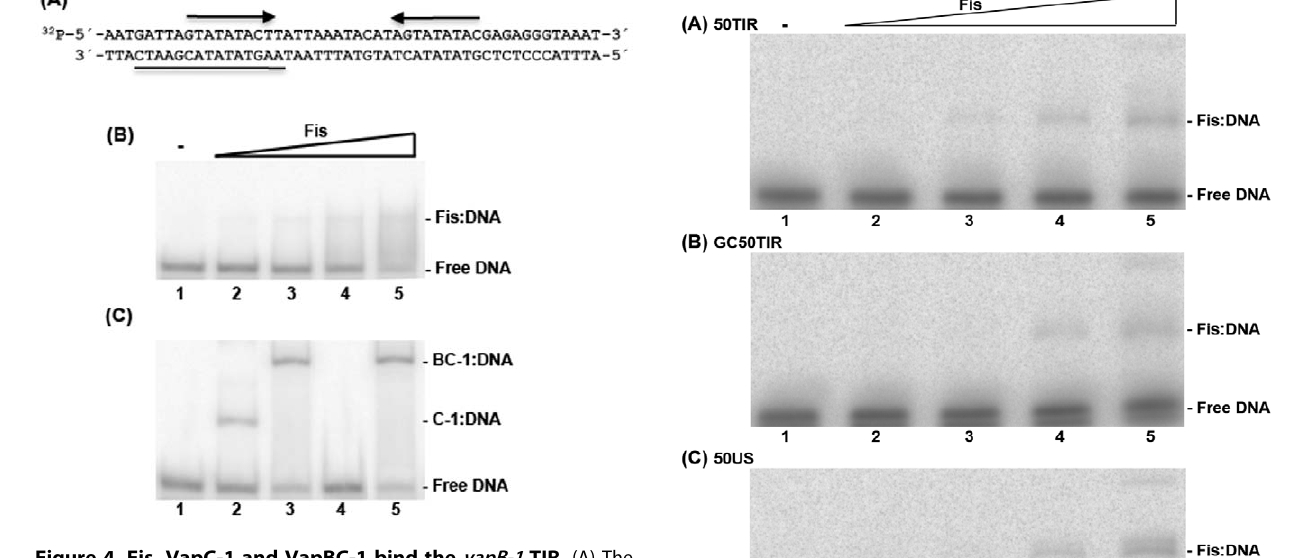
1:DNA mobility as the concentration of protein increased. This observation suggests that VapBC-1 formation is not required prior to DNA binding, and that VapB-1 can associate with VapC- 1:DNA complexes. A double-mutant TIR substrate, 2M50TIR, was created by including a G to C transversion in the TG50TIR substrate, which altered the upstream half of the inverted repeat. Nucleotide changes in both sides of the inverted repeat completely abolished VapBC-1 interaction with the TIR sequence (Fig. 6D). half compared to that observed with 50TIR ( data not shown ). This